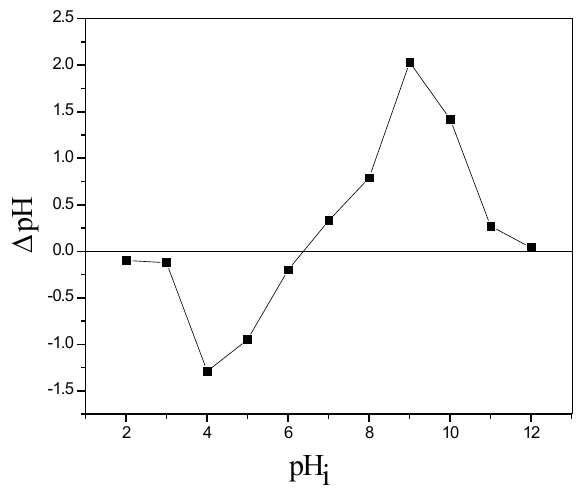
Figure 7: Potential of zero charge of cellulose.